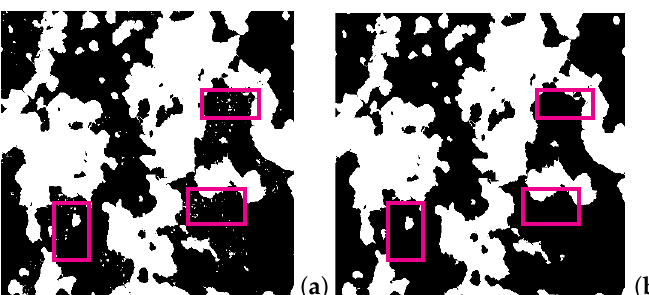
Figure 6. Denoising in postprocessing: ( a ) binary image shown in monotonic color (magenta rectangle in Figure 5d) with disturbances shown in white in black grains and vice versa; ( b ) corresponding image of ( a ) after denoising (magenta rectangle in Figure